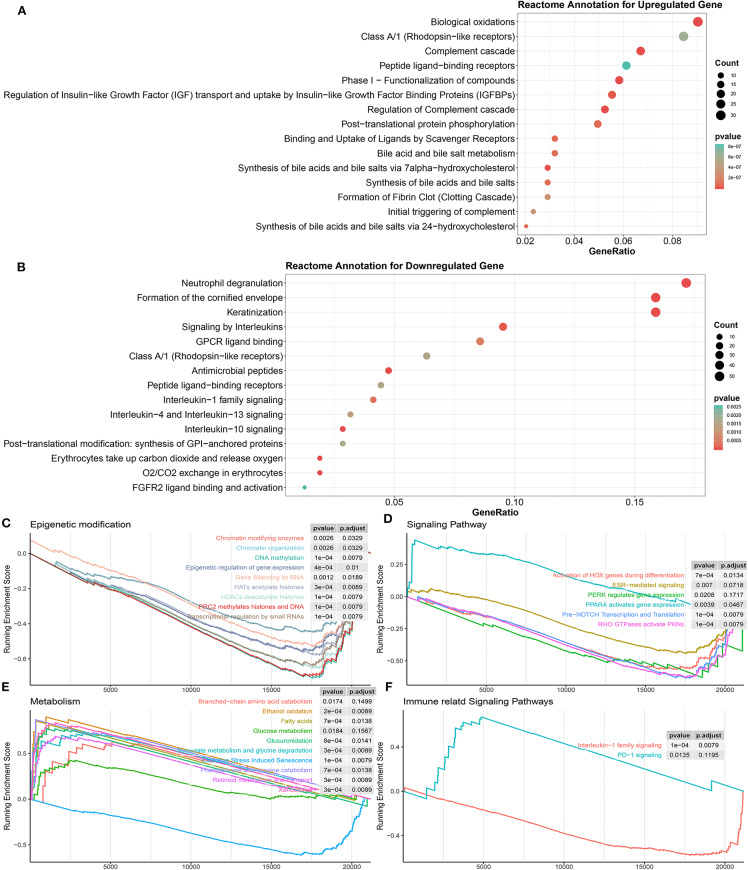
Biological processes correlated with identified DEGs in inflamed responders. (A) Detailed function annotation of upregulated genes in inflamed responders (compared to inflamed non-responders). (B) Functional annotation of downregulated genes in inflamed responders (compared to inflamed non-responders). (C–F) GSEA shows four dimensions of the molecular function of DEGs across inflamed responders. Running enrichment score >0 means this pathway is upregulated in inflamed responders; running enrichment score <0 means this pathway is downregulated in inflamed responders.